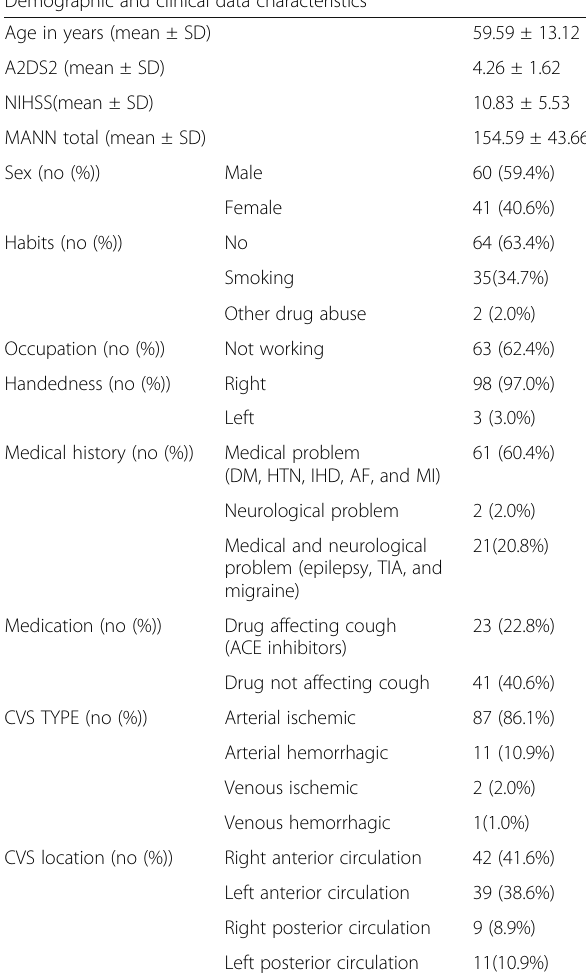
Table 1 Demographic and clinical data characteristics for all patients Demographic and clinical data characteristics